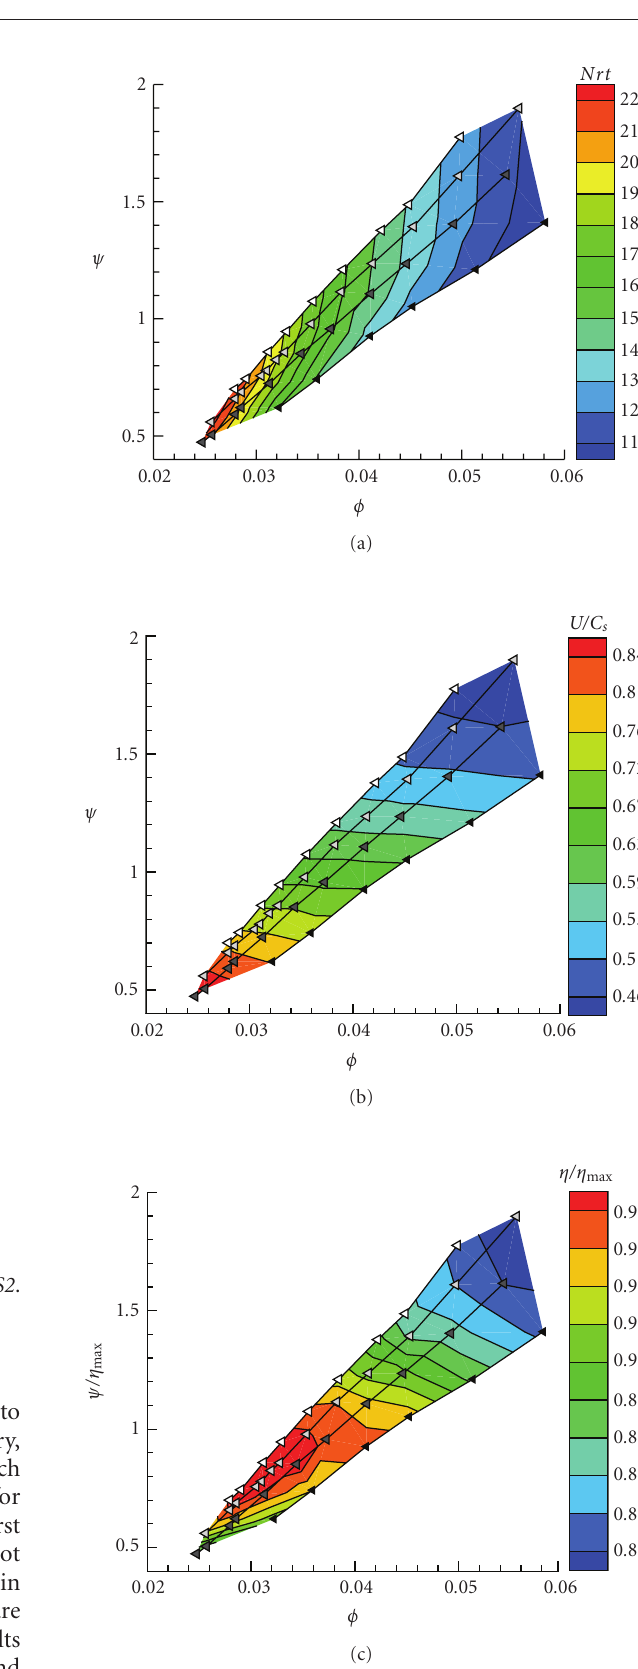
Figure 5: (a) Interpolation of speed, (b) reduced speed, and (c) e ffi ciency